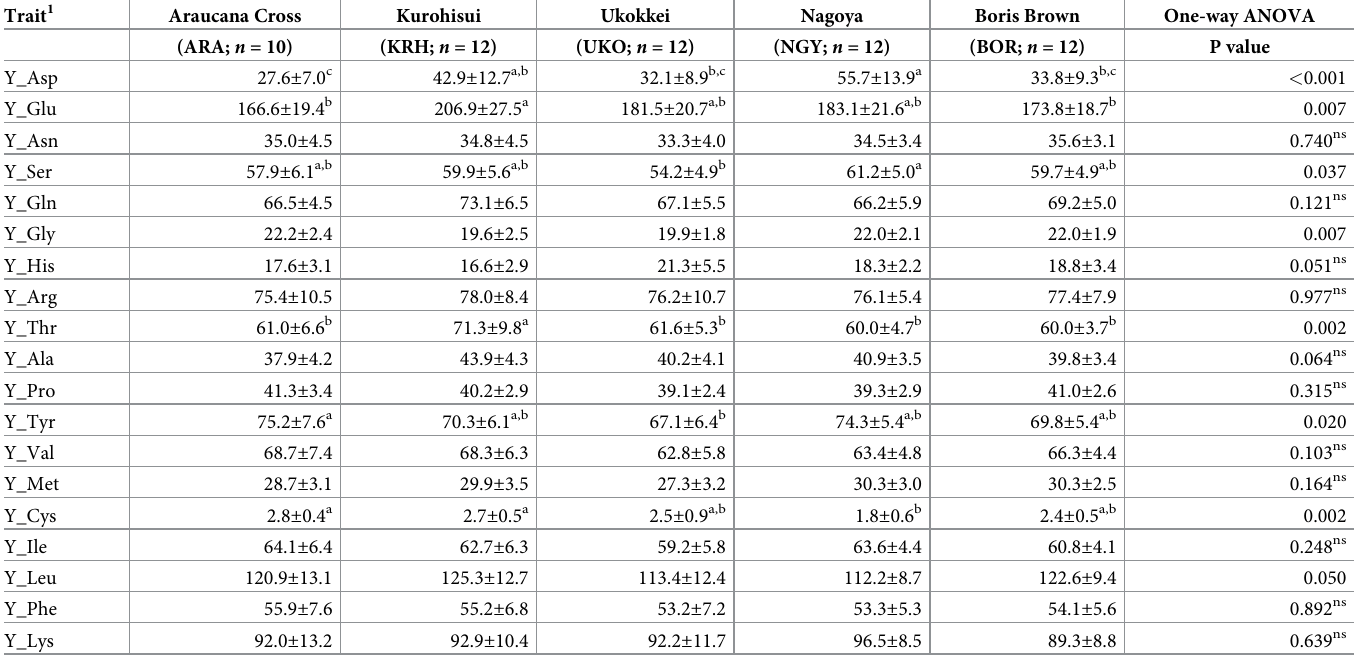
1 Trait abbreviations are shown in Materials and Methods. Amino acids concentrations are shown in μ g/mL. ns not significant (P > 0.05). a-d The same superscript letter are not significantly different among the genotypes at P > 0.05 in each trait (Tukey’;s HSD